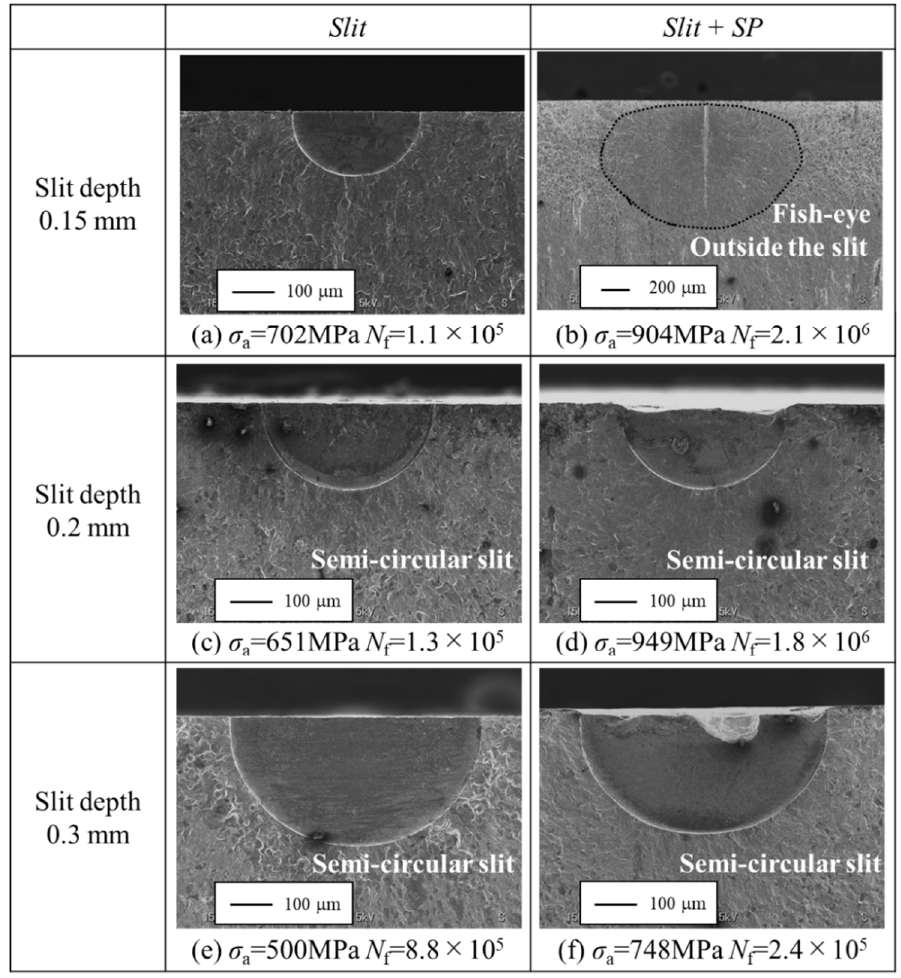
Figure 9. Fracture surface observation results of slit specimens.